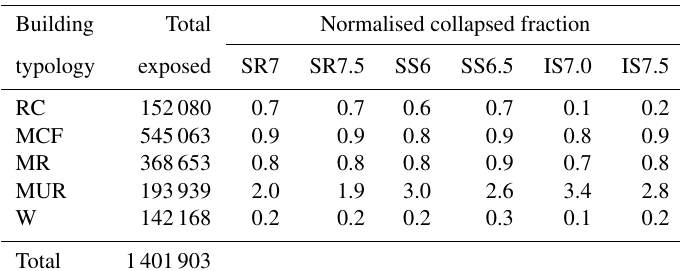
Figure 13. The distribution of (a) non-residential and (b) residential replacement costs for maximum-magnitude scenarios considered for the San Ramón Fault and the Santiago splay fault (moment magnitude 7.5 and 6.5 respectively). The gross loss ratios represent the calculated losses in each scenario over the total insured value after the application of policy conditions and deductibles. The residential replacement costs are the costs to repair or replace buildings and their contents damaged in each scenario. The residential replacement cost maps for all scenarios are given in Fig. S8. Table 4. The fraction of collapsed residential buildings by building class (Table 1) normalised to the total collapse fraction in each earthquake scenario. SR: San Ramón; SS: Santiago splay; IS: intra-slab. The number indicates the moment magnitude of the earthquake source. Values greater than 1 indicate that the building typology is more likely to collapse than the